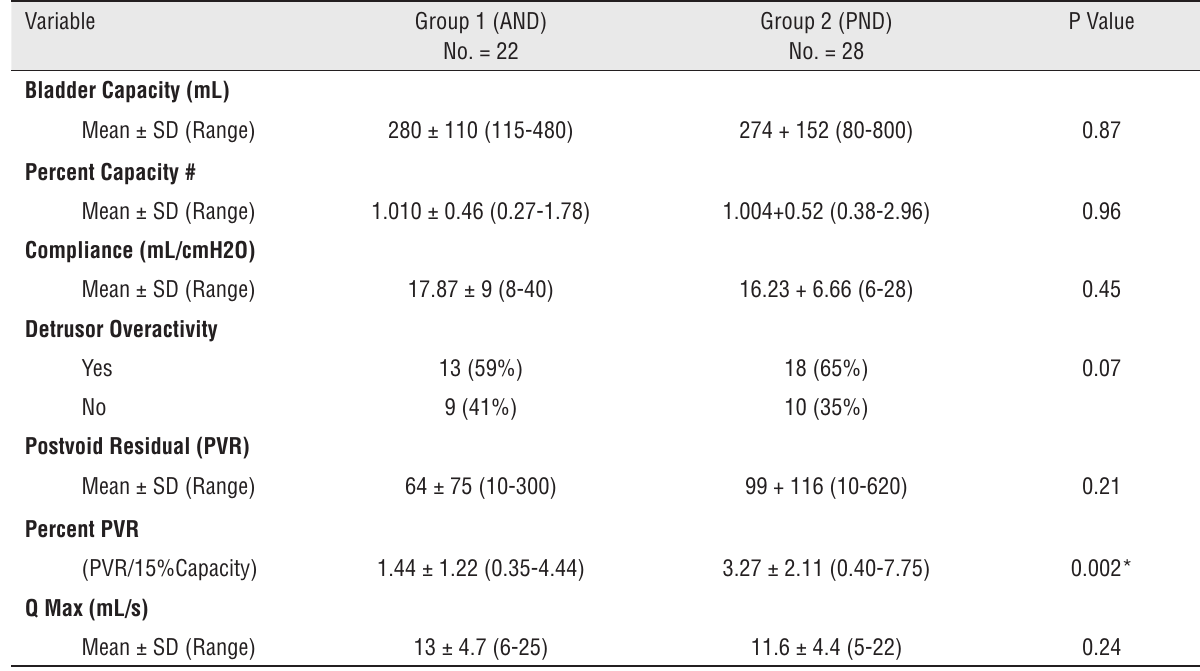
Table 2 - Comparison of urodynamic parameters between the two groups.